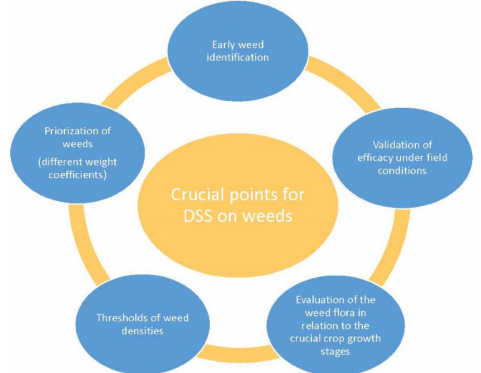
Figure 2. Potentially crucial points for weed-based